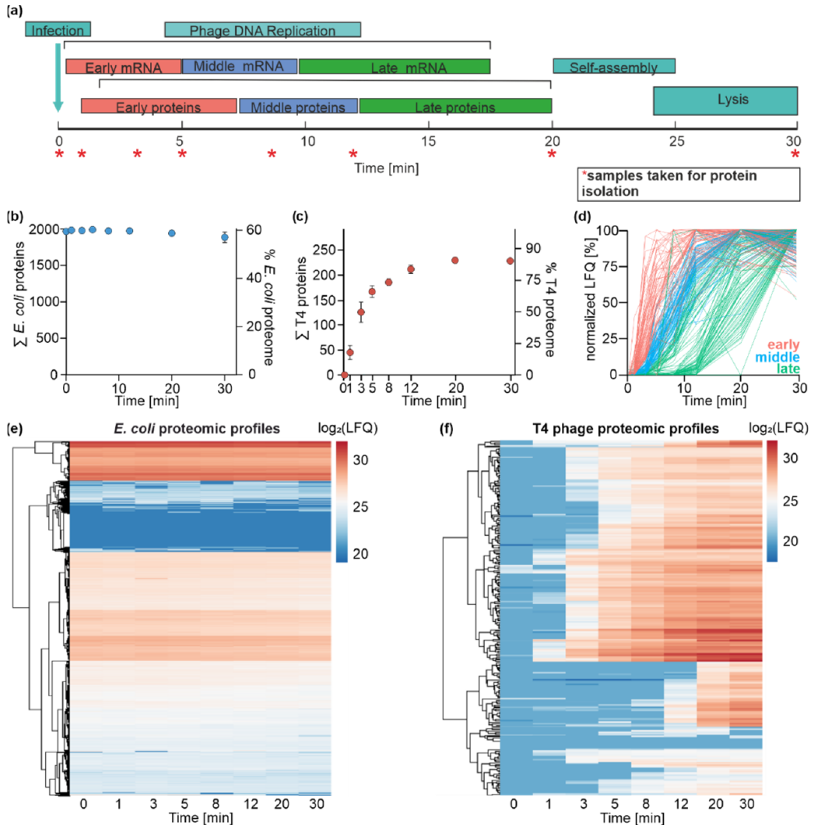
Figure 3. Time-resolved dual-proteome of T4 phage infection of E. coli . ( a ) Schematic illustration of infection-phase-specific gene expression during T4 phage infection. The time points at which samples were collected for the dual-proteome are indicated with an asterisk. ( b ) Monitoring of E. coli proteins over the time course of infection. The left y -axis identifies the absolute number of detected proteins, and the right y -axis depicts the coverage of the annotated E. coli proteome ( n = 3). E. coli proteome is not significantly altered throughout the infection process. ( c ) Monitoring of T4 phage proteins over the time course of infection. The left y -axis identifies the absolute number of detected proteins, and the right y -axis depicts the coverage of the annotated T4 phage proteome ( n = 3). The diversity of the T4 phage proteome increases throughout the infection. After 20 min, 85% of annotated T4 phage proteins are identified. ( d ) Assignment of T4 phage proteins to specific temporal groups. Criteria for the classification of T4 phage proteins are shown in the graph: early (red), middle (blue), and late (green) based on the time frame of the onset of protein detection and its maximal abundance values. Plots of all T4 phage proteins over the time course of infection based on mean MaxQuant LFQ values normalized to the highest mean LFQ value of each protein. Proteins are colored by classification based on their temporal appearance ( n = 3). ( e ) Heatmap representation of the clustered E. coli protein abundance over the time course of infection based on log2- transformed LFQ values ( n = 3). ( f ) Heatmap representation of T4 phage protein log2-LFQ intensity over the time course of infection ( n = 3).